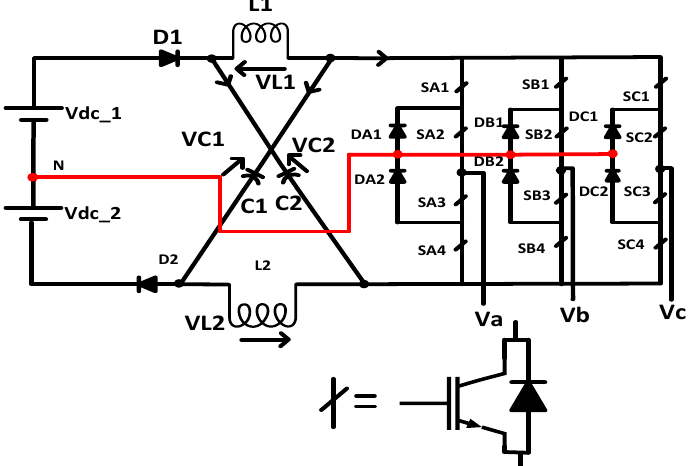
Figure 1. Existing three-level ZSI with one impedance network.